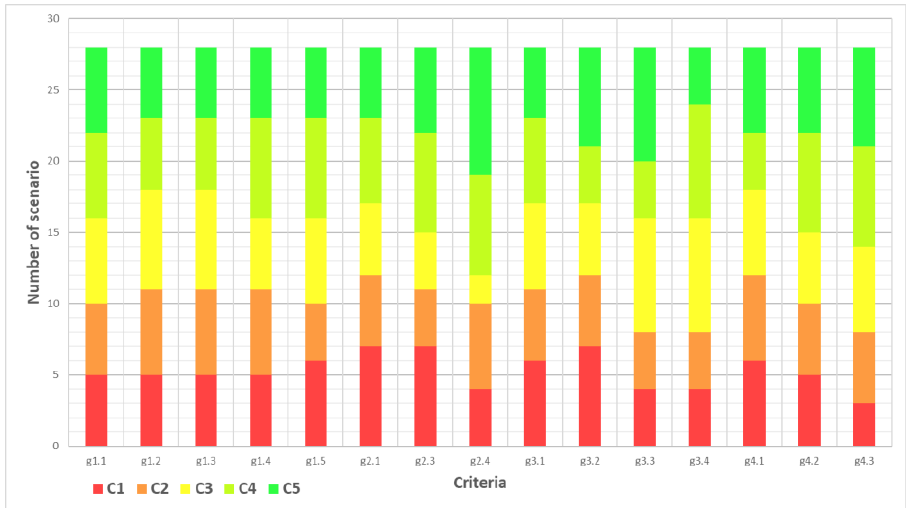
Figure 8. Distribution of the retrofit scenarios within the different ranking categories.